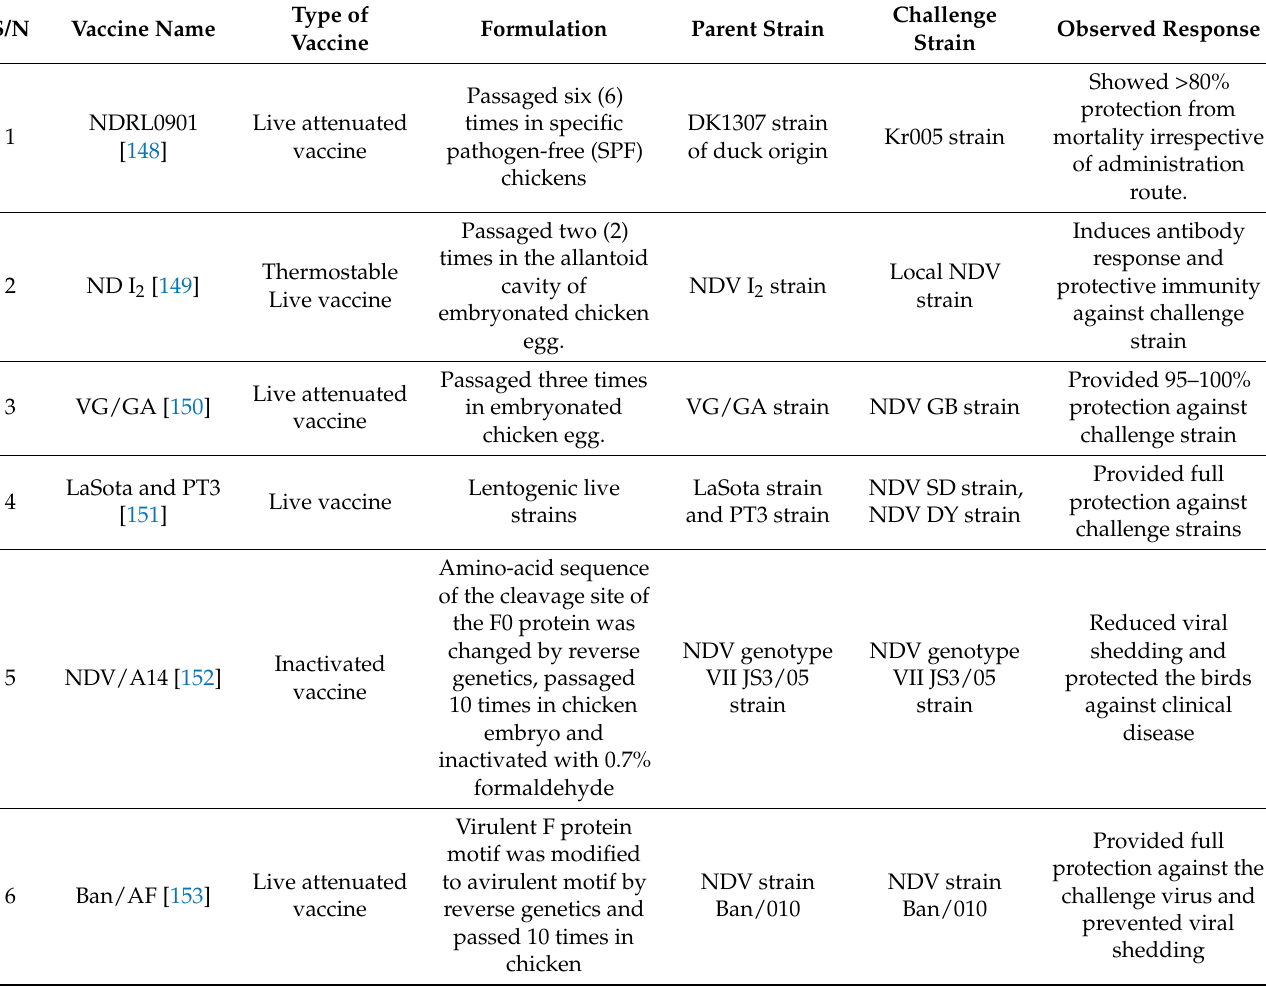
Table 2. Available vaccines against Newcastle disease in